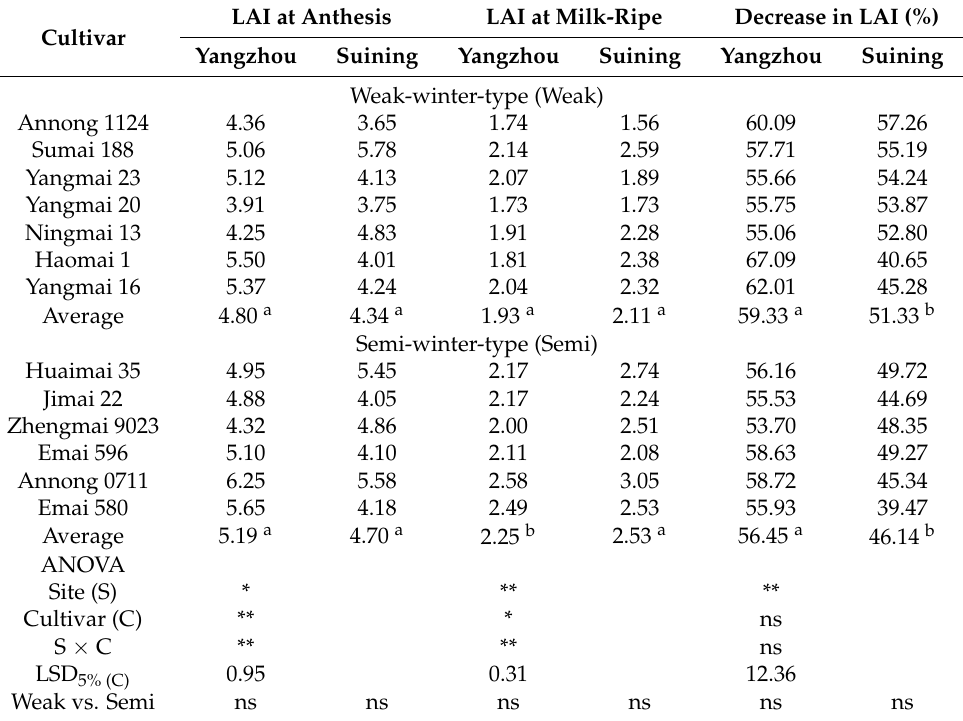
Table 8. Leaf area index (LAI) and decrease in LAI of weak-winter-type and semi-winter-type cultivars planted in southern (Yangzhou) and northern (Suining) areas of the Yangtze River basin, China, in